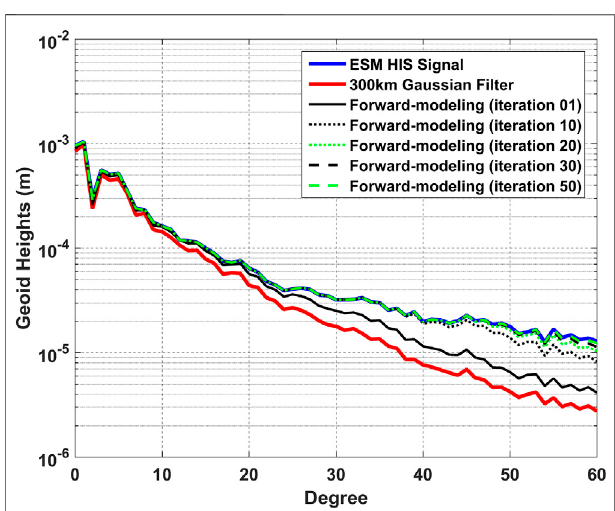
FIGURE5| Degreevariancesofgeoidheightfordifferentsolutions.Blue line: ESM HIS signal; Red line: SHCs after 300 km Gaussian fi lter; Black line and other dotted lines: Forwarded SHCs after several iterations.